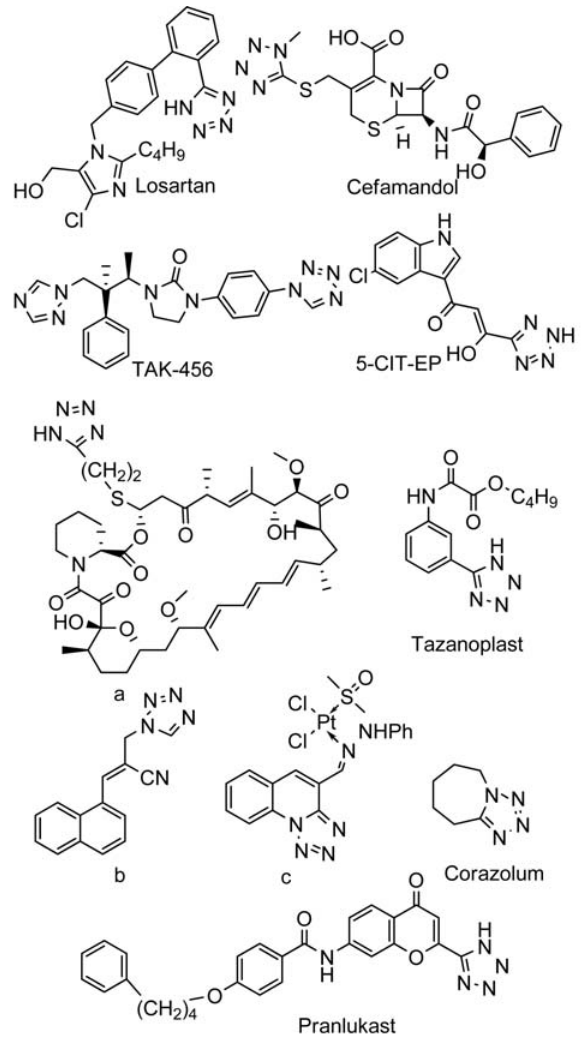
Figure 1. Structures of known tetrazole ring containing drugs avai- lable on the market and related agents in clinical